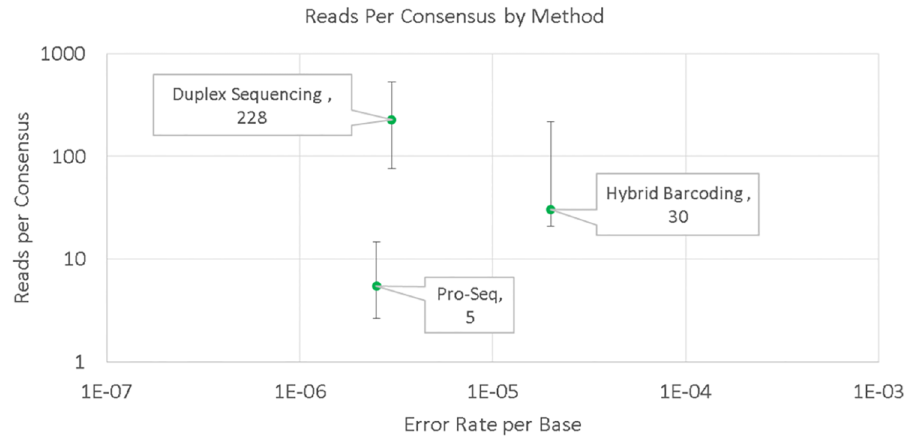
Fig 8. Average reads per consensus (RPC) required to represent a fixed number of input genomes, as a function of cfDNA error rate. Pro-Seq RPC was compared to estimates of RPC for duplex and hybrid barcoding using supplementary data [18]. Sequencing efficiency for Pro-Seq was calculated as on-target bases passing all Pro-Seq filters, divided by all (unfiltered) on-target bases (n = 30 runs). Error bars represent maximum and minimum reported values for the relevant data sets. Hybrid barcoding RPC estimates are also comparable to those from